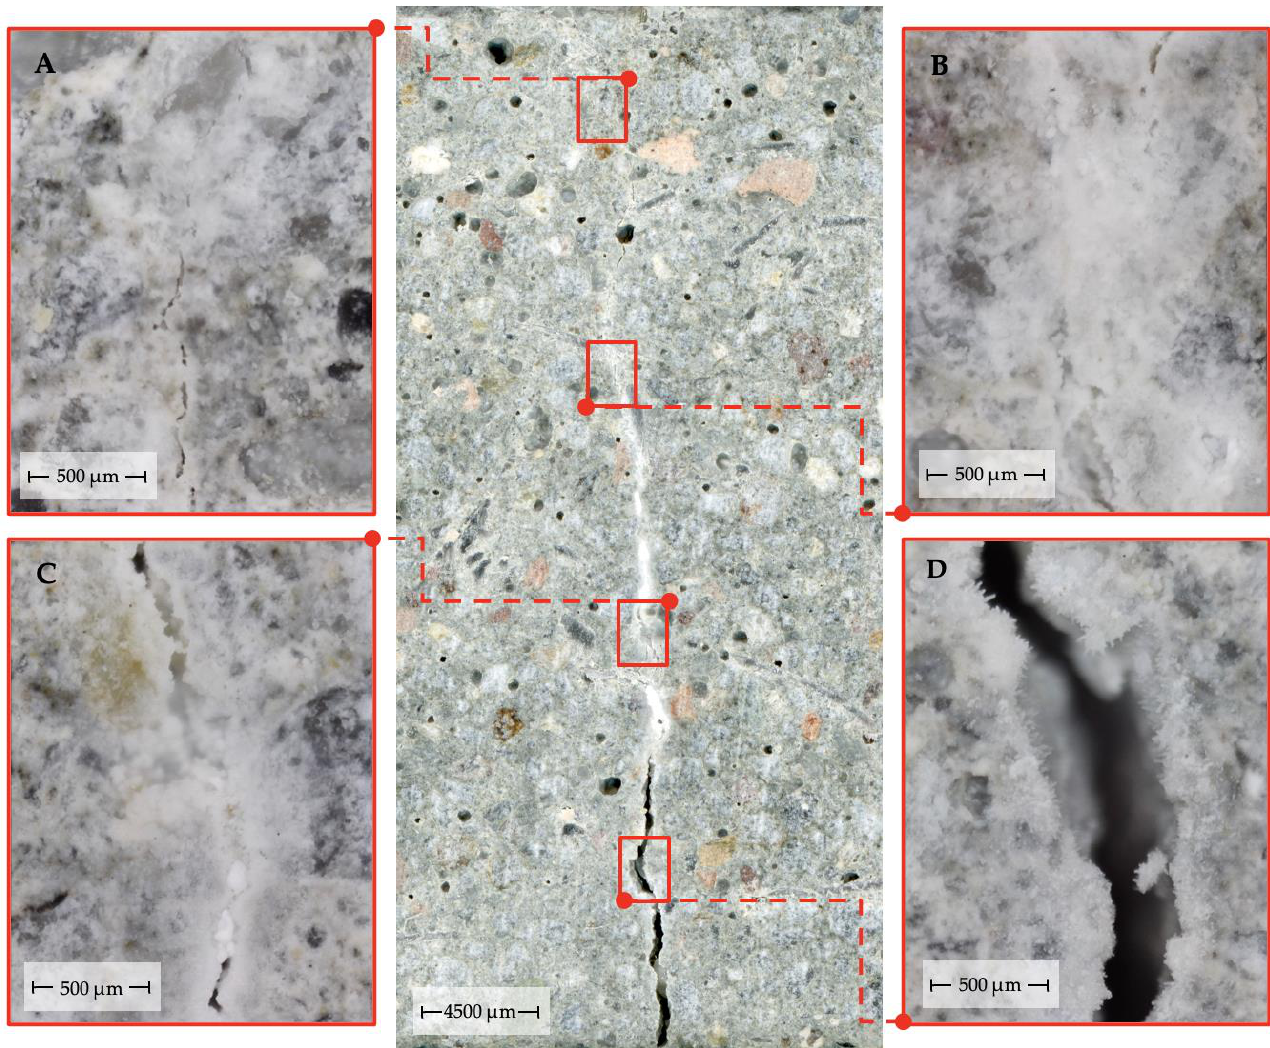
Figure 4. Typical microscopic observations of self-sealing of cracks in mortar samples. ( A ): partial lack of sealing of a crack of <50 μm wide; ( B ): complete sealing of a crack of 100 to 250 μm wide; ( C ): partial sealing of a crack of 250 to 350 μm wide; ( D ): aggregated layers of newly formed material on the surface of a crack of >350 μm wide.